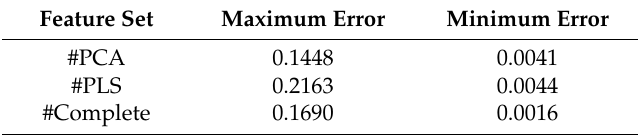
Table 4. Prediction error of different paraffin odor levels based on SVM.